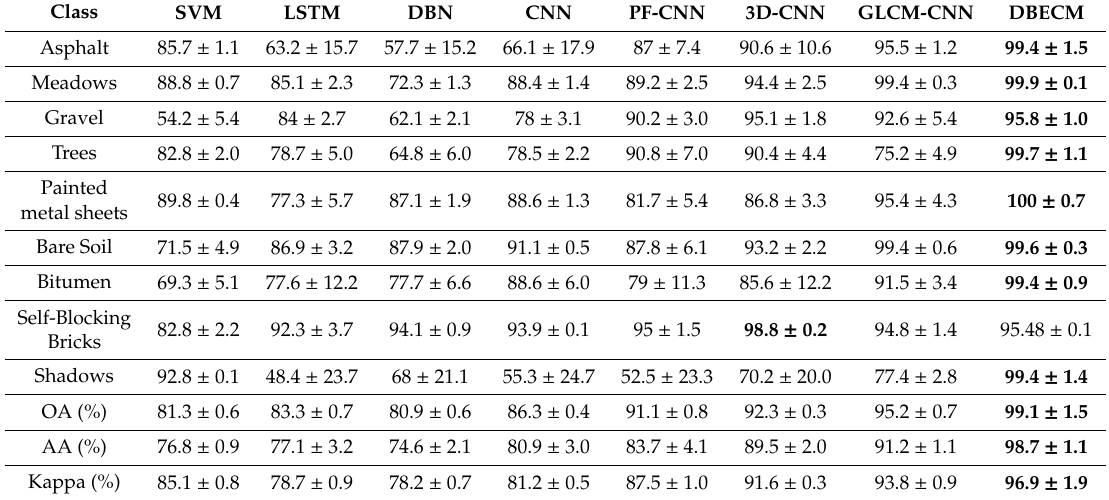
Table 4. Classification results of the seven methods in the Pavia University dataset in the 10% train